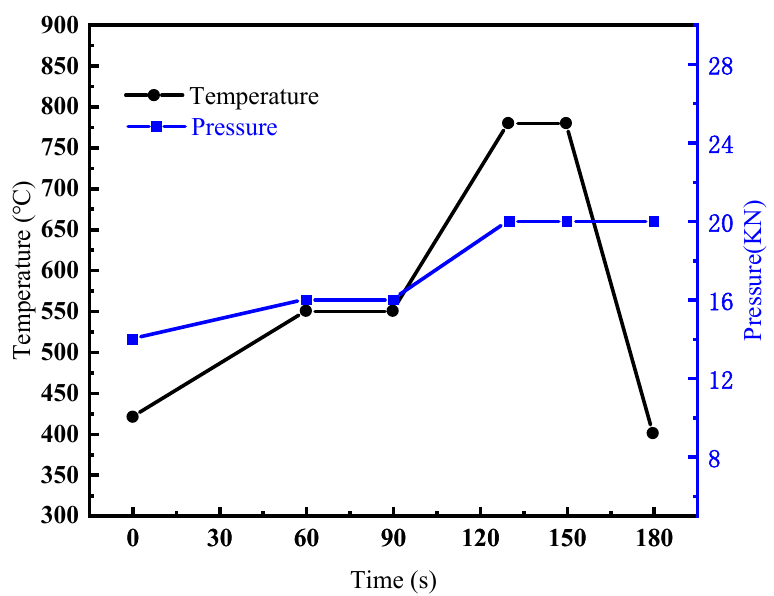
Figure 1. Sintering process of powders.